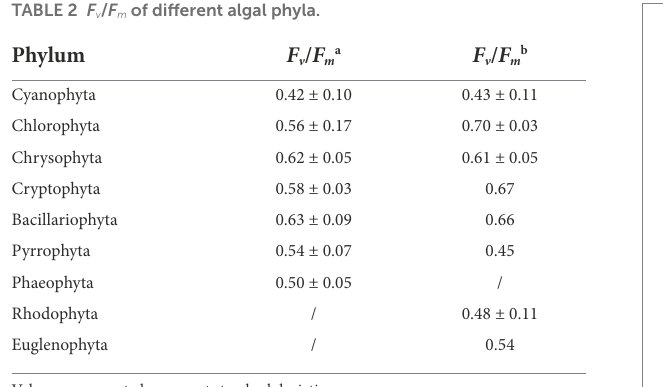
TABLE 2 F v / F m of different algal phyla.